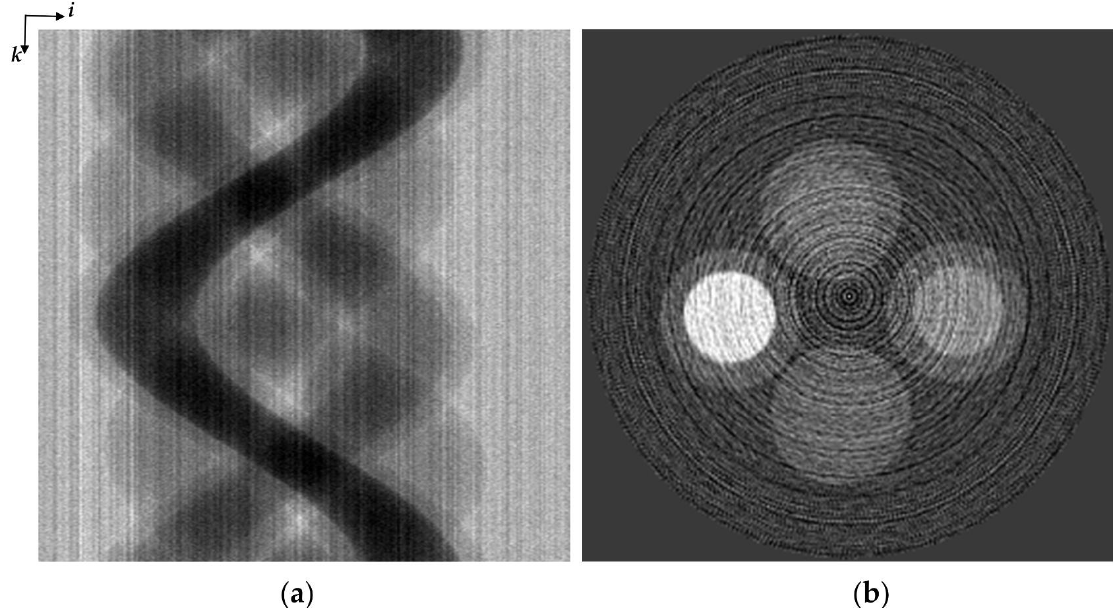
Figure 1. An example of stripe patterns in the sinogram and ring artifacts in the CT images obtained with the flat-field correction. ( a ) A sinogram generated from flat-field corrected projections of a four-tube contrast phantom acquired by a Si PCXD with an energy threshold of 14 keV. ( b ) The CT image reconstructed from the projection data shown in Figure 1a.